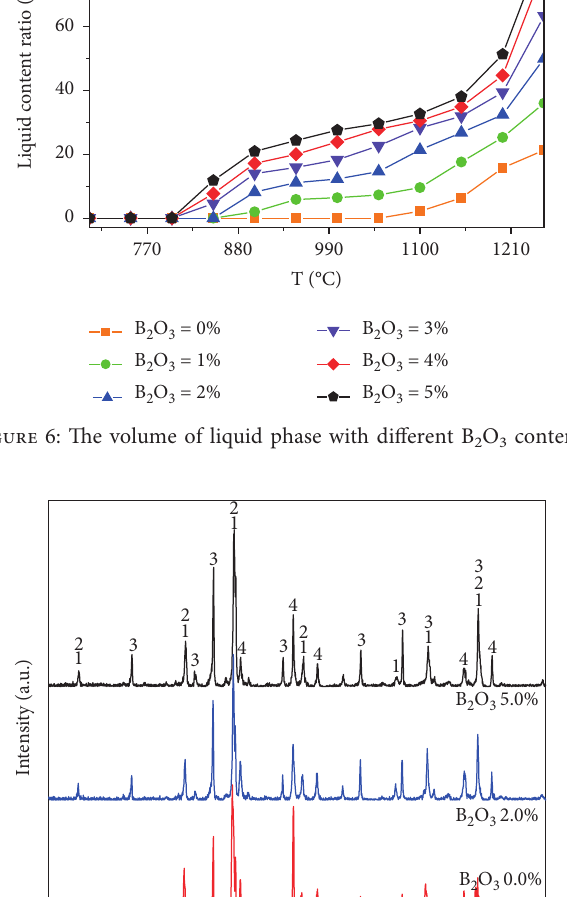
· Fe · SiO 2 O 3 ; 4: 2CaO 2 .